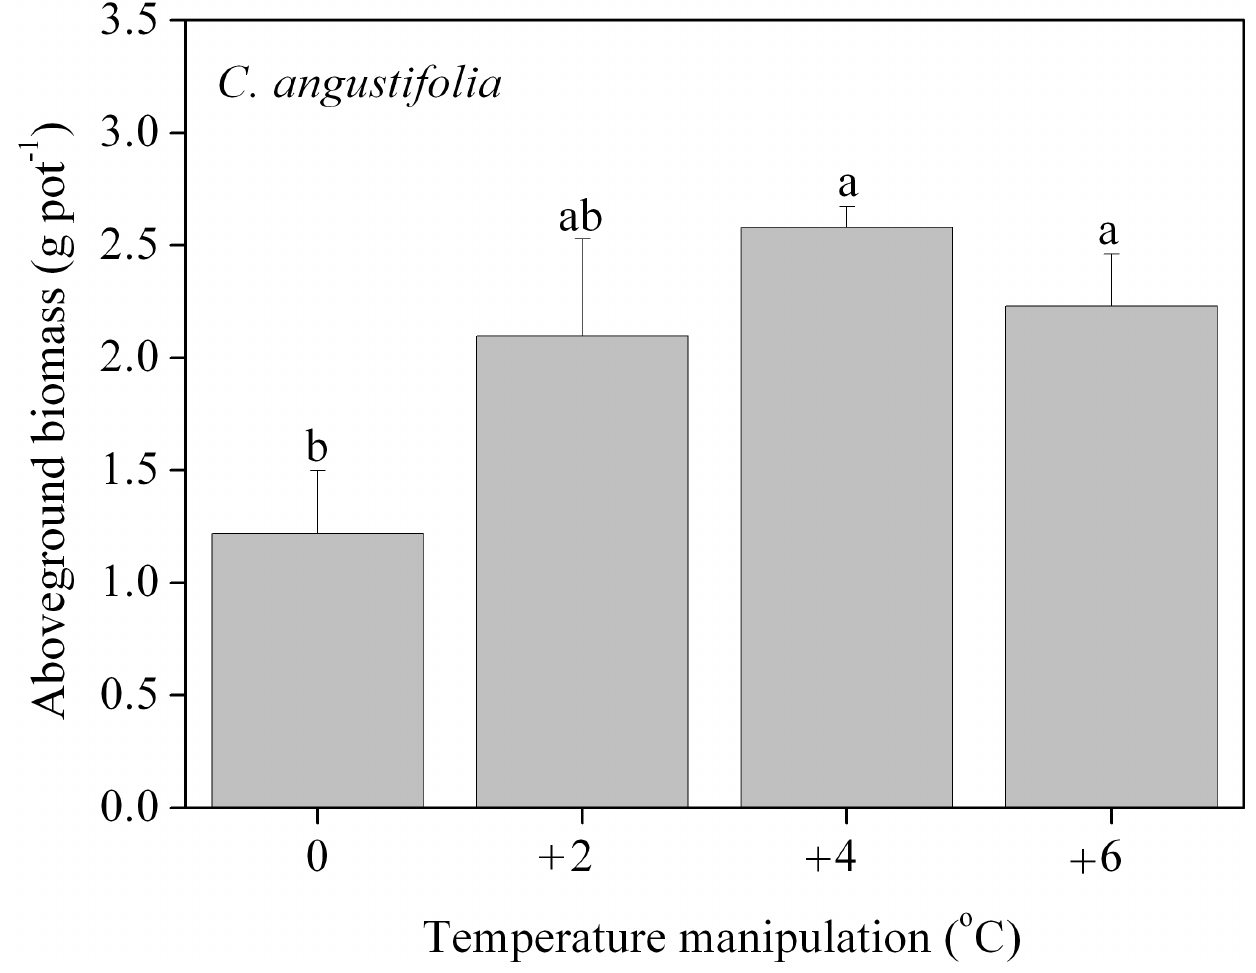
Figure 7. Aboveground biomass of C.angustifolia after secondary growth for one month. Different letters shared by the bars indicate significant differences ( p , 0.05) between the temperature manipulations. The error bars represent means 6 1 standard error.